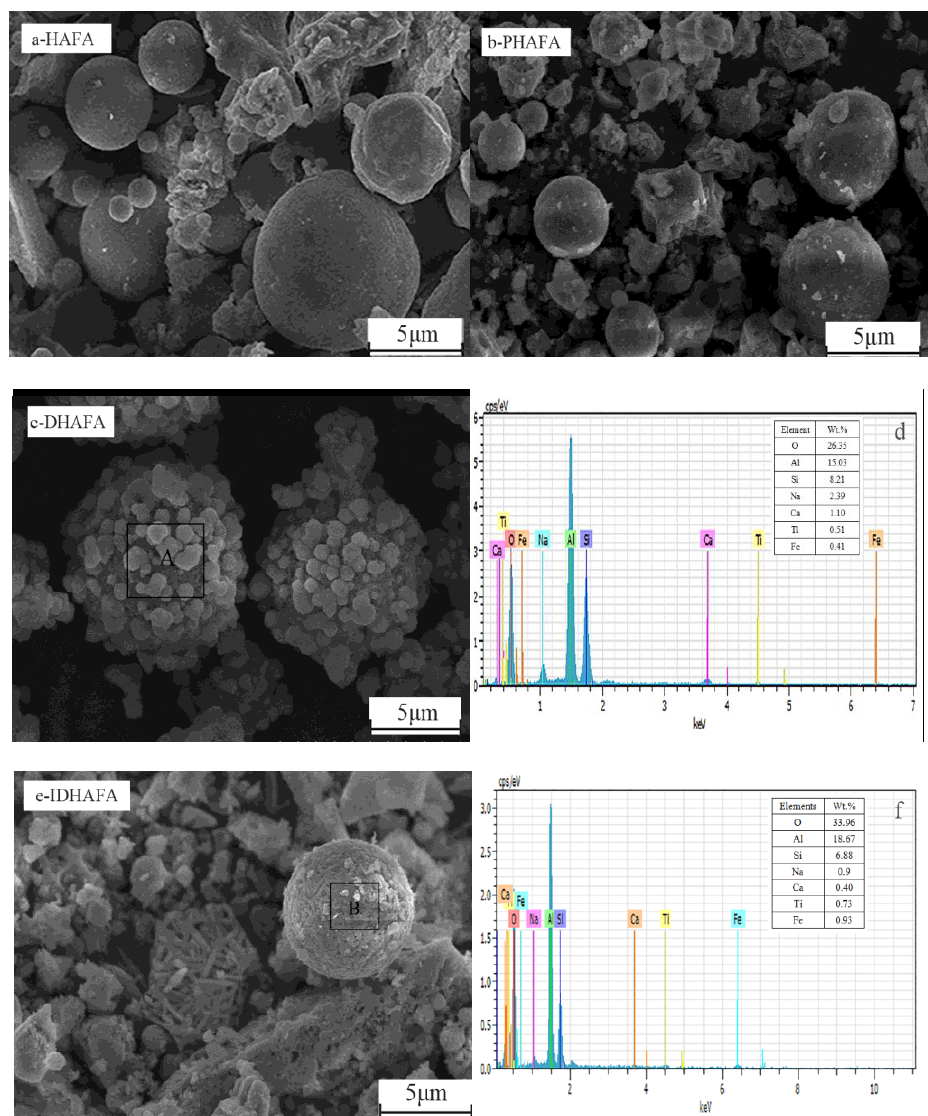
Figure 12. Scanning electron microscopy (SEM) and energy-dispersive X-ray spectroscopy (EDS) results: ( a ) HAFA, ( b ) PHAFA, ( c , d ) DHAFA, ( e , f ) IDHAFA.